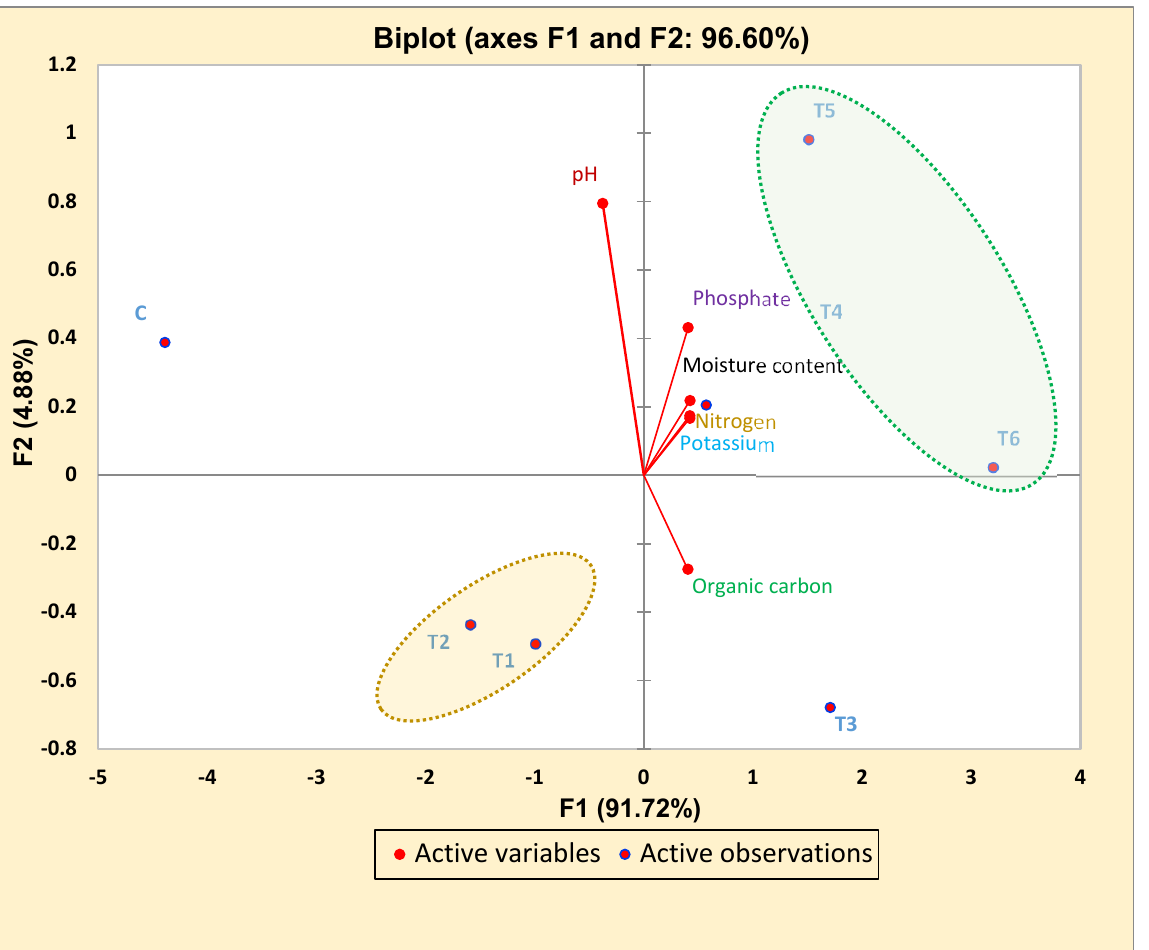
Figure 4. PCA analysis showing the correlation between the different treatment groups and variables of soil nutrients.